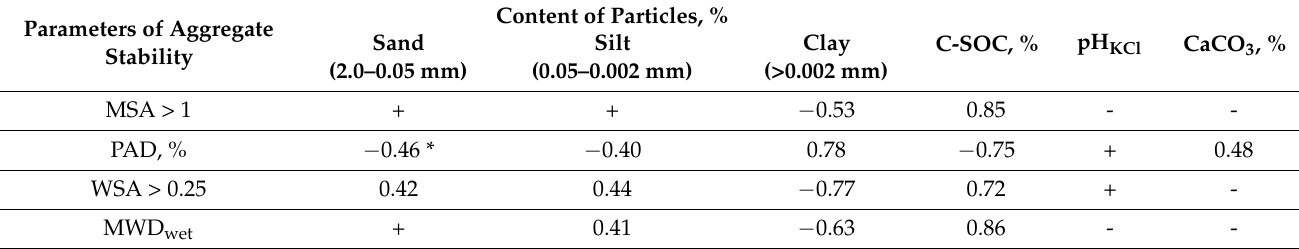
Table 4. Pearson’s correlation matrix: interactions between soil aggregate stability and soil